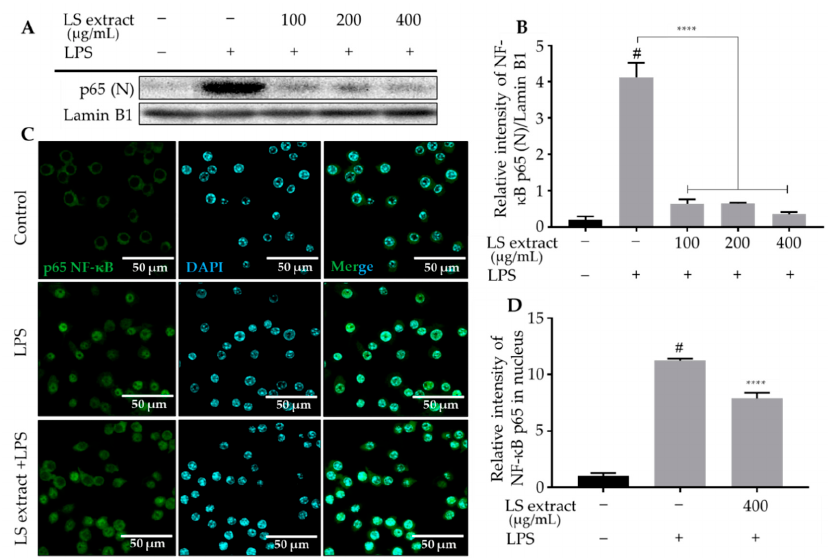
Figure 6. The inhibitory effects of LS leaf extract on translocation of the p65 NF- κ B subunit in LPS-stimulated RAW 264.7 cells. Cells were pretreated with LS leaf extract for 24 h, followed by LPS (1 µ g / mL) stimulation for 18 h. The nuclear (N) p65 NF- κ B subunit was detected by Western blotting ( n = 3) ( A ). The relative band intensity of p65 (N) to lamin B1 (nuclear loading control) was quantified using Image J ( B ). Cells were pretreated without or with 400 µ g / mL of LS leaf extract followed by LPS stimulation, and then labeled with an anti-NF- κ B p65 antibody tagged with Alex Fluor 488 (Green) and nuclear-counterstaining 4 (cid:48) ,6-diamidino-2-phenylindole (DAPI; blue) ( C ). The fluorescent intensity of nuclei was analyzed using MetaMorph software ( n = 30) ( D ). Control, cells treated with only culture medium; LPS, cells treated with LPS only (1 µ g / mL); LS extract + LPS, cells treated LS leaf extract (400 µ g / mL) followed by LPS (1 µ g / mL). Values represent the mean ± SD; scale bar, 50 µ m. Statistical significance was calculated by t -test and one-way ANOVA. # p < 0.05 vs. cells treated with media only; n. s., not significant; **** p < 0.0001 vs. cells treated with LPS only.